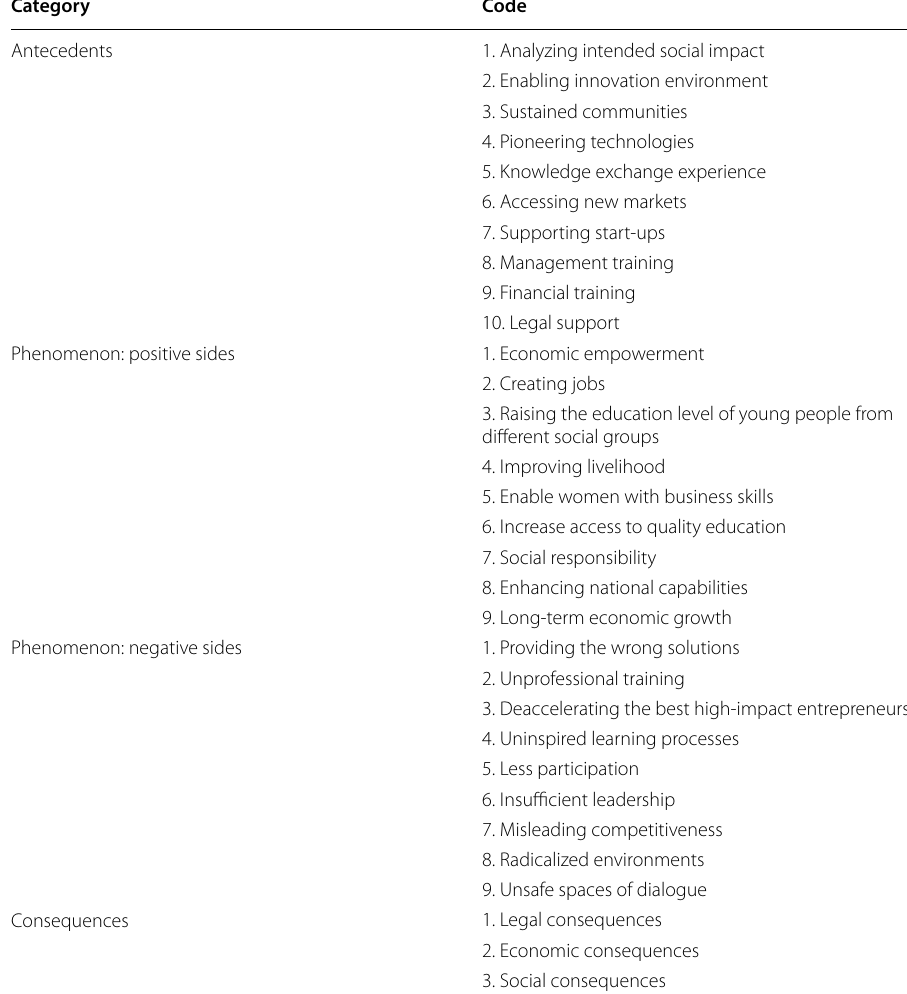
For the ( Antecedents ), the main themes comprised the organizations’ two‑liner mission description according to their answers are illustrated in Table 4